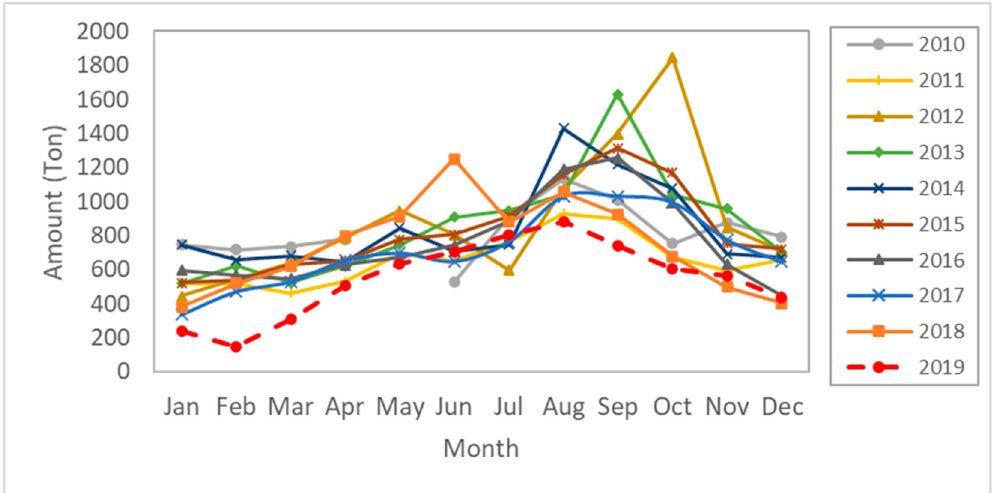
Figure 12. The monthly amount of sardine catches (Ton) in Egypt Mediterranean water for the period 2010–2019 (Source: [8]).